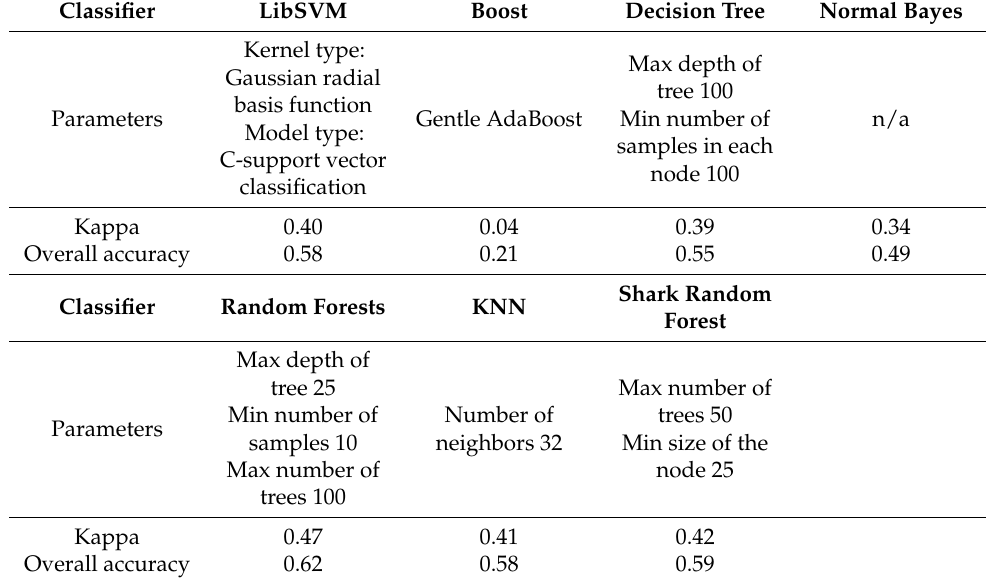
Table 2. Kappa and overall accuracy of different models of forest formations.